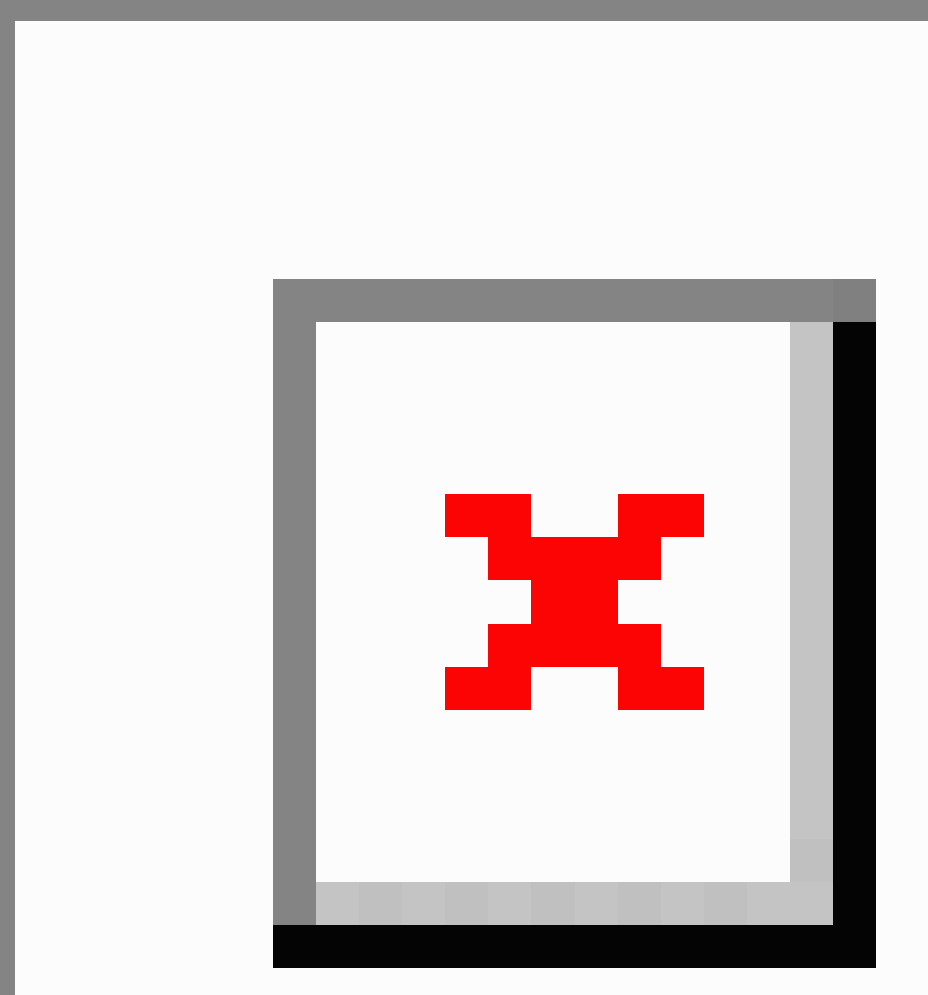
Figure 3. Entering, tracking, and receiving feedback of physical activity on